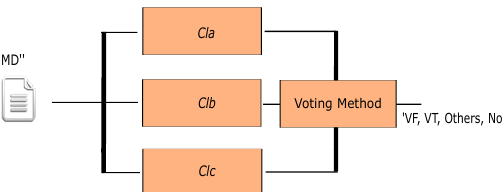
Figure 4. Parallel classifier combination and final voting. All classifiers receive all data and must obtain a four-class decision through a majority voting among results generated by each classifier.